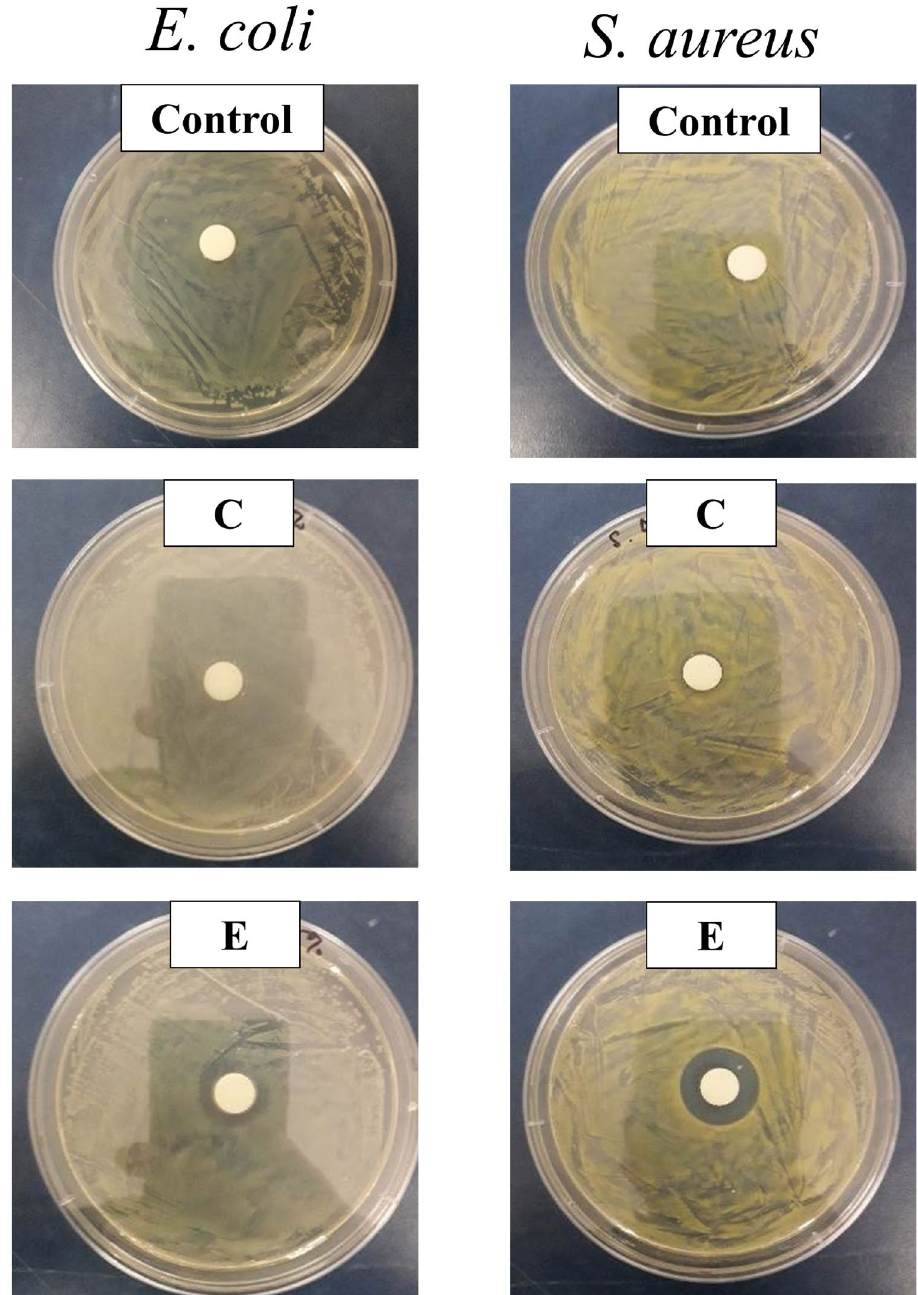
Figure 2. Inhibition zone of hand gels against E. coli and S.